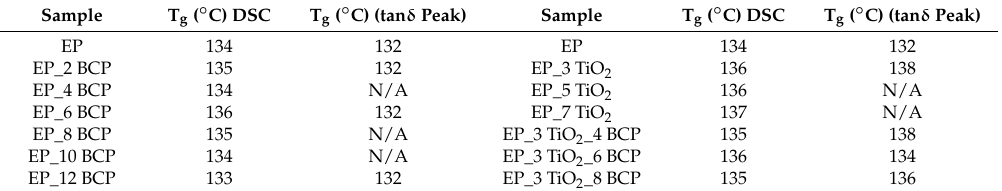
Table 2. Glass transition temperature (T g ) of reference and different types of modified epoxy